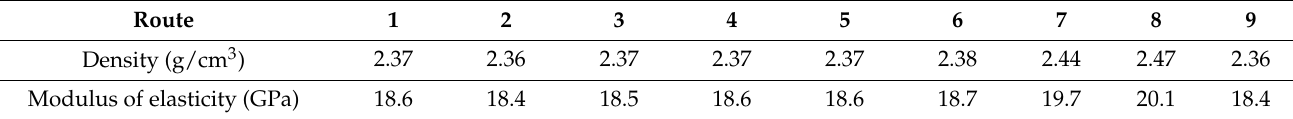
Table 7. Modulus of elasticity of the porous